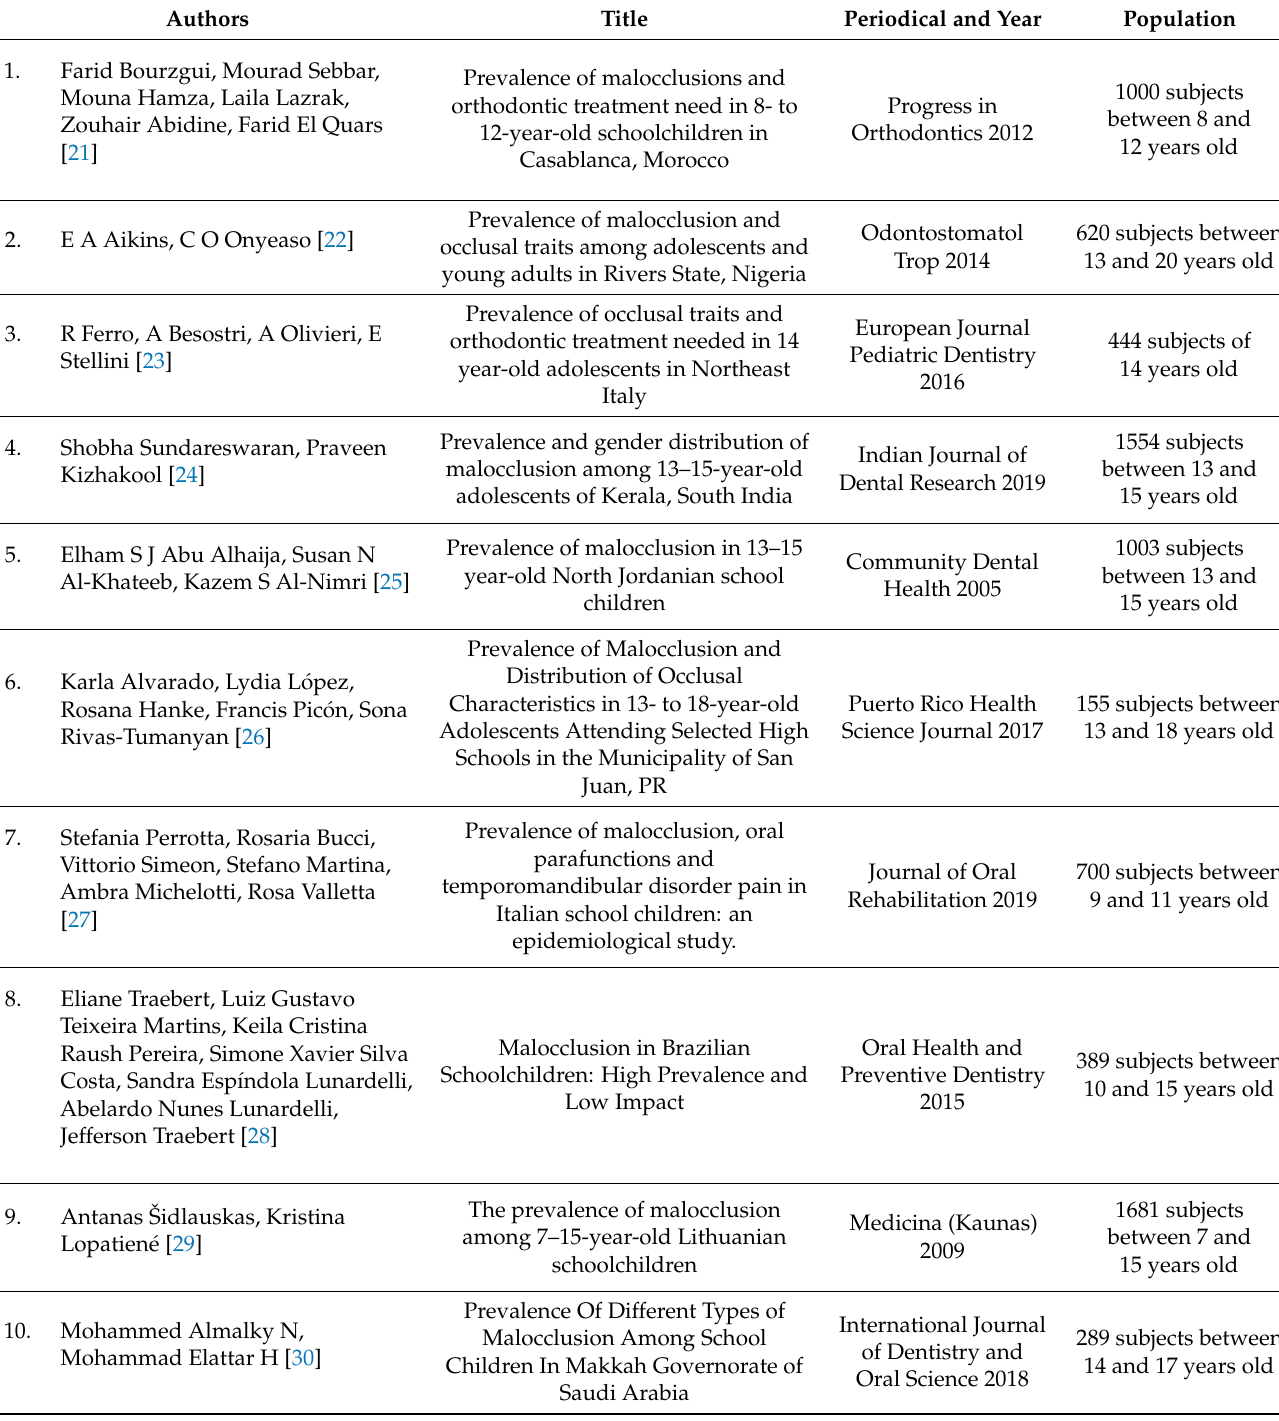
Table 1. Authors, title, periodical, year and population of the articles